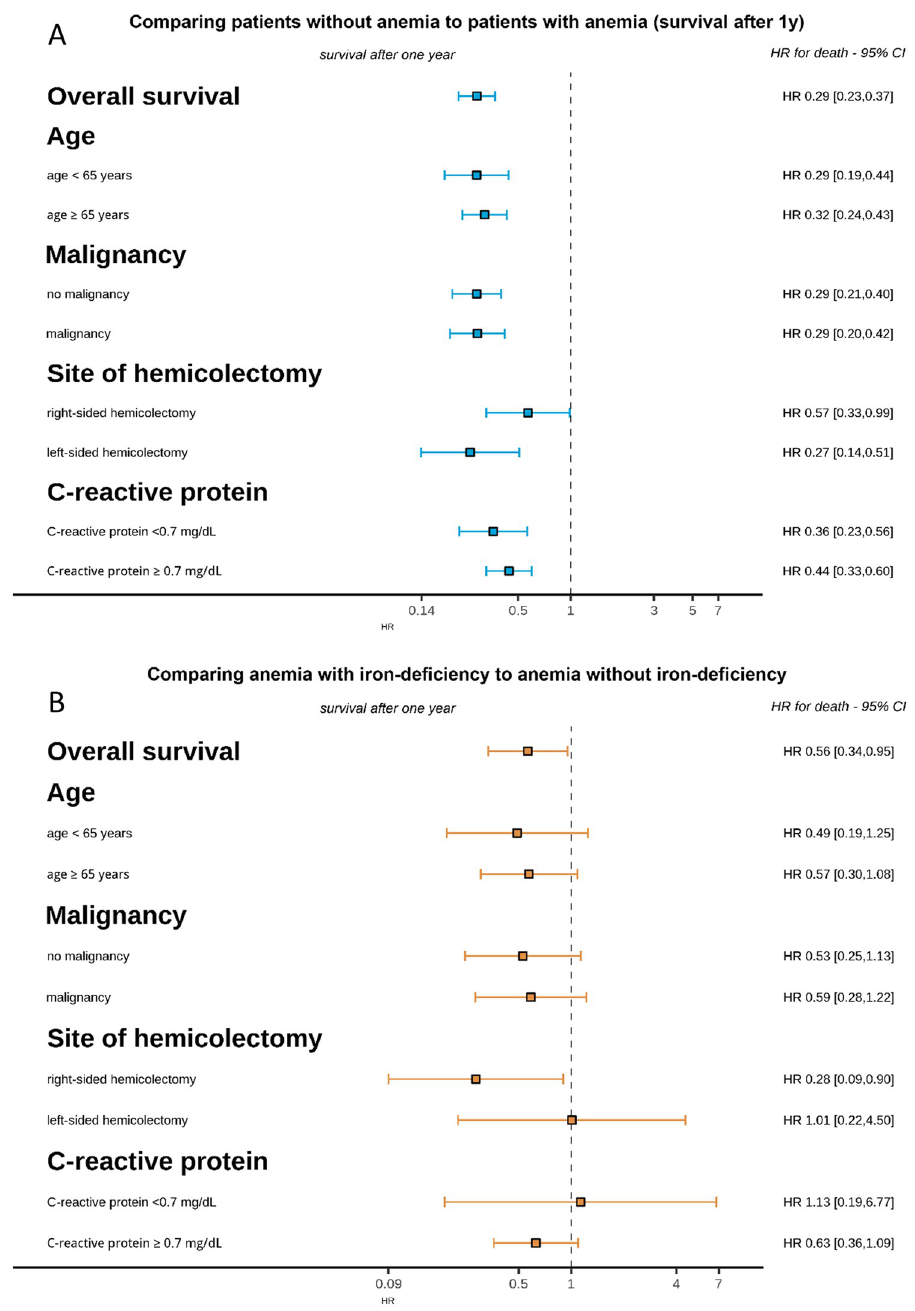
Fig 3. Subgroups analysis comparing hazard ratios and 95% confidence intervals for 1-year survival in indicated patient subgroups (A) with and without anemia and (B) with iron deficiency anemia versus anemia without iron deficiency (corresponding survival analysis is shown in S1